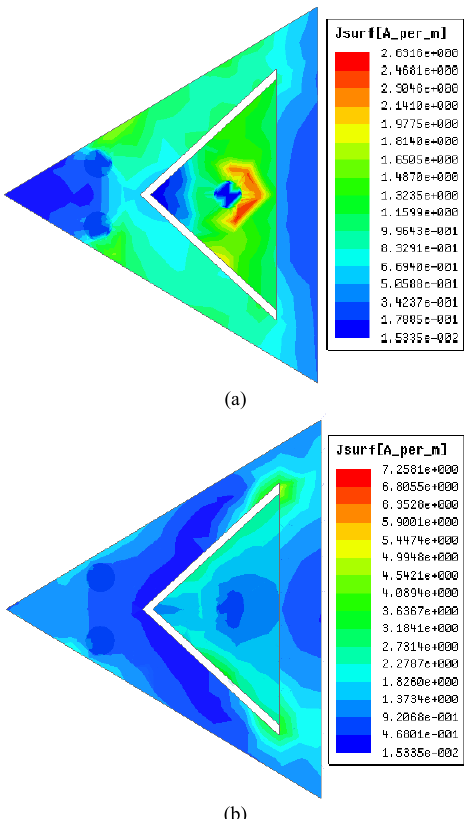
FIGURE 12 . Surface current density on the patch of the suggested full design at: (a) 4.5 (b) 10.9 GHz.